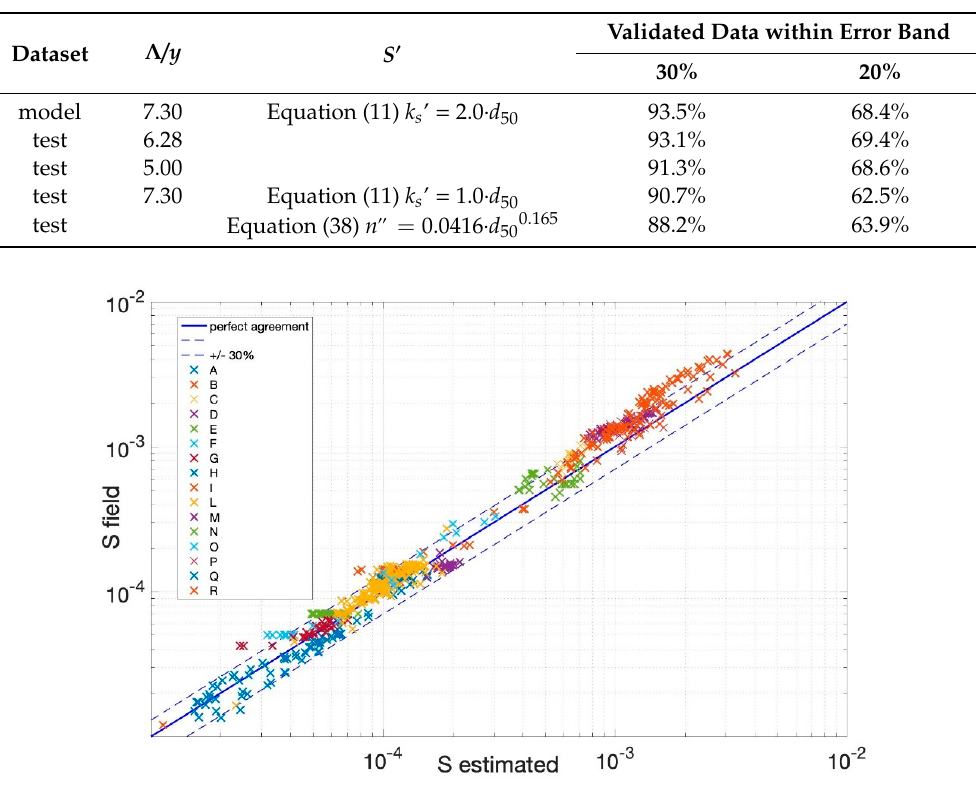
Figure 6. Comparison of estimated and observed total energy slope (the dashed lines represent the ± 30% error band). Note: the total energy slope S is calculated accounting for the grain component S' obtained by Manning–Strickler Equation (39). Table 3. Sensitivity analysis of the bed surface roughness and the dune geometry predictor.